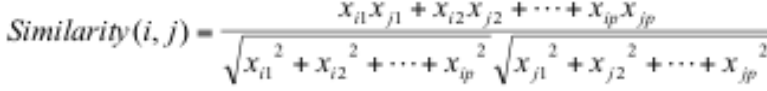
Figure 2. Formula calculating minimal